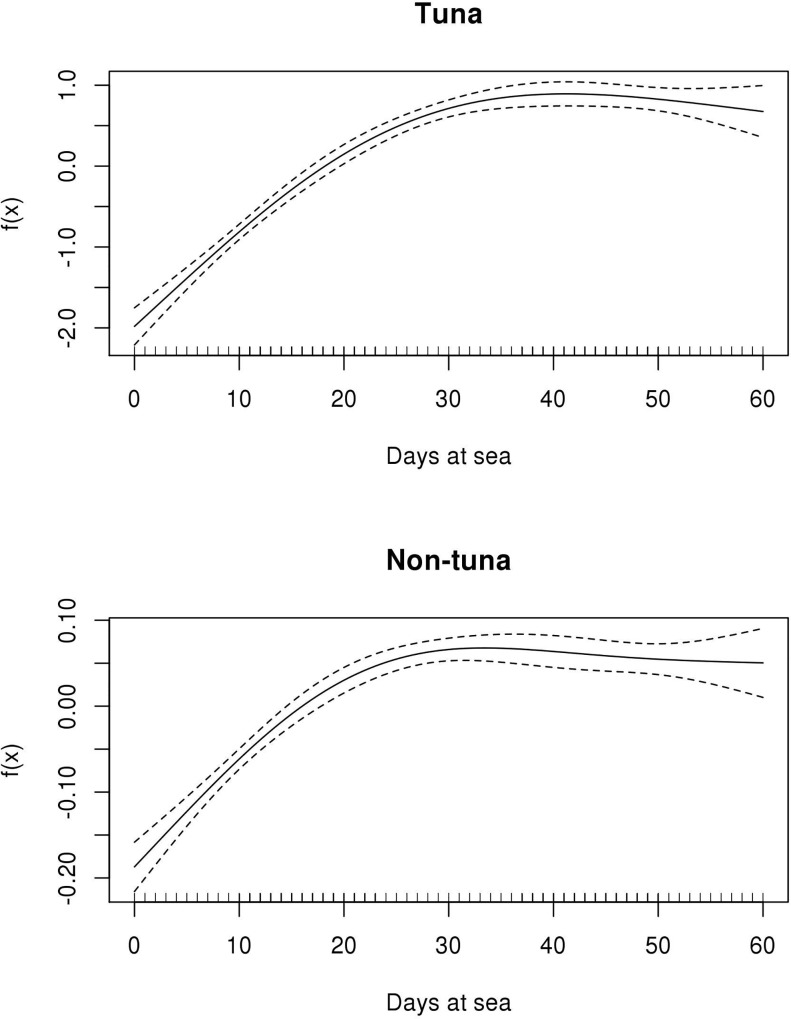
Functional shapes of the non-parametric relationship between biomass and days at sea with 95% confidence intervals (dashed lines), for tuna and non-tuna species.